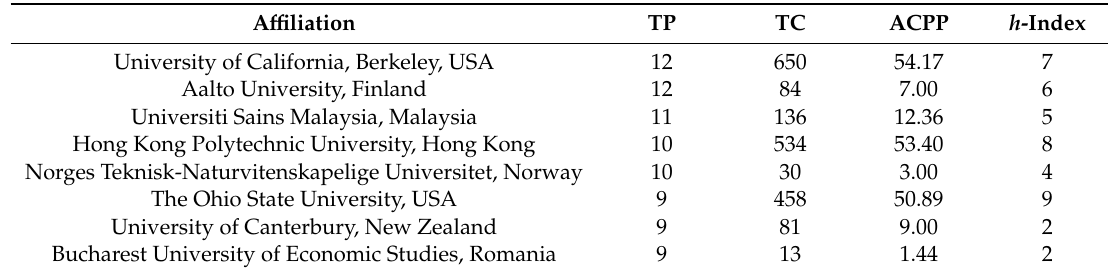
Table 5. Most productive institutes in the field of green products.